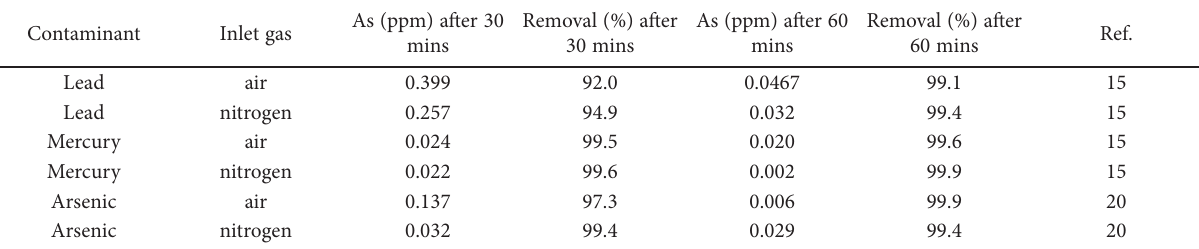
Table 2. Flotation results for of 5 mg/ L (ppm) of different heavy-metals ions using s-octanoyl-cys, C(surfactant) = 0.01M and pH = 8. (Reproduced from 15